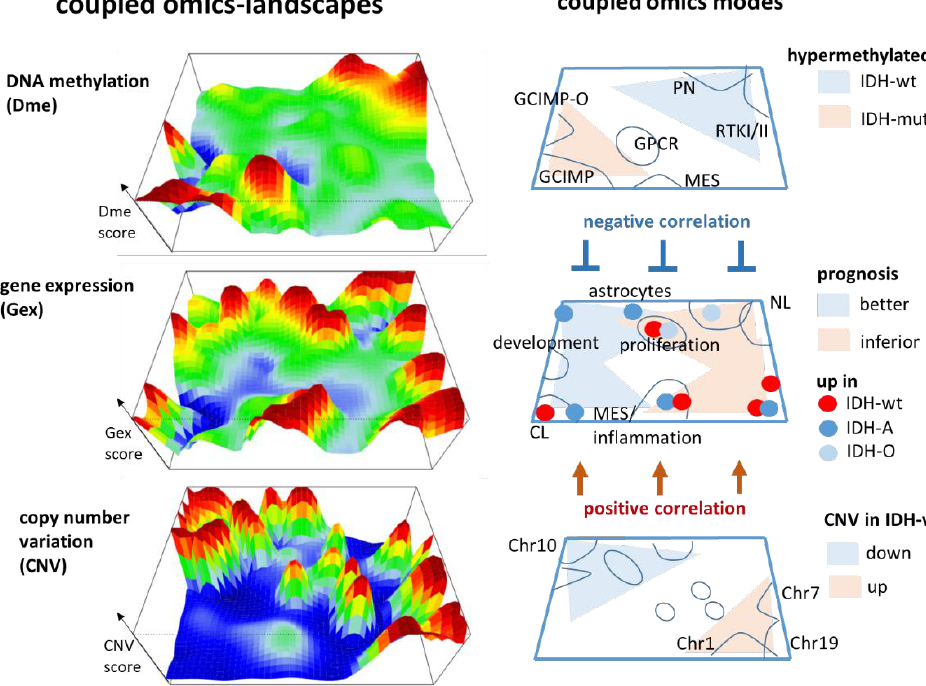
Figure 8. Multi-omics cartography of gliomas. DNA methylation, gene expression, and copy number variations are visualized as three layers of mutually linked landscapes where the (red) peaks refer to variant gene-centred features (DNA promoter methylation, gene expression, and copy number gains, respectively) and (blue) valleys to virtually invariant features. The right part schematically assigns the key topological features and their regulation in LGG.